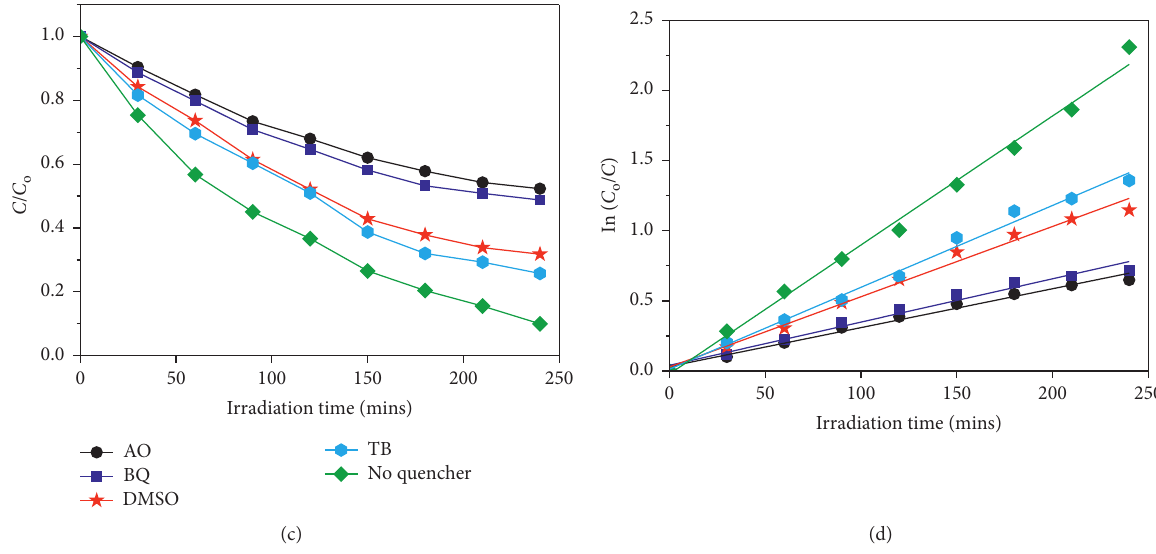
Figure 4: (a, b) Photocatalytic activities of P25, MS, MMS, and n %MMS/rGO composites; (c, d) photocatalytic activities of 3%MMS/rGO with different trapping agents for RhB degradation under visible light irradiation. Table 1: Rate constant of the photocatalytic degradation of RhB on MS, MMS, and n %MMS/rGO